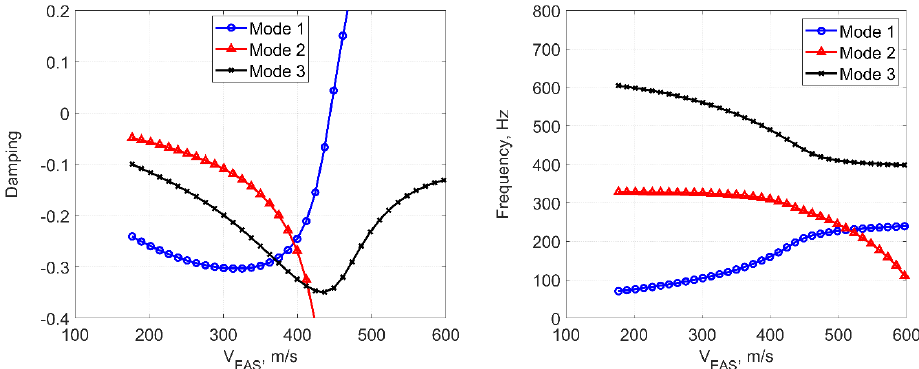
Figure 11. V − g ( left ) and V − f ( right ) plots with M = 0.9 and P 0 = 400 kPa.